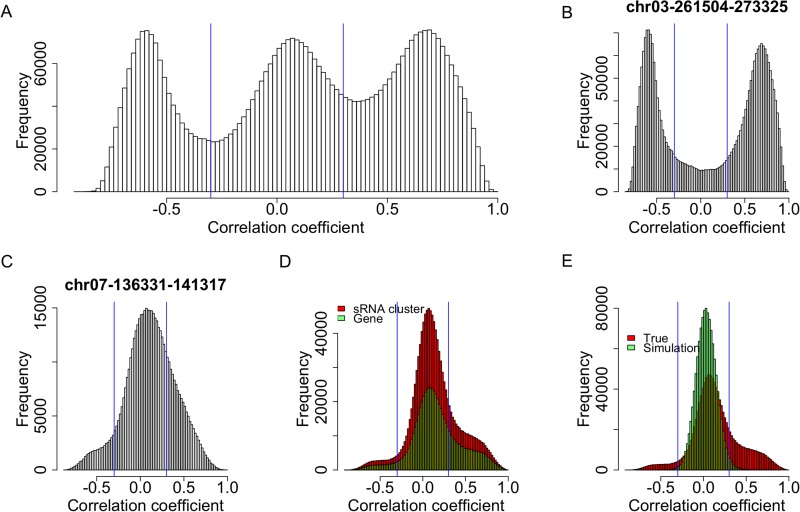
Expression correlations between s-traits originating from the same sRNA clusters.(A) The distribution of expression correlations between s-traits originating from the same sRNA clusters. (B) The distribution of expression correlations between s-traits originating from chr03-261504-273325. (C) The distribution of expression correlations between s-traits originating from chr07-136331-141317. (D) Comparison of the distribution of expression correlations between s-traits originating from the same mother genes and s-traits from the same sRNA clusters. (E) Comparison of the distribution of expression correlations for the simulation data and the true data excluding s-traits from chr03-261504-273325 and chr07-136331-141317.